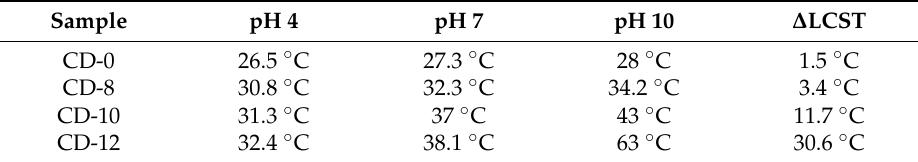
Figure 7. Plots of: ( a ) transmittance vs. temperature of poly(CD-NIPAM) and poly(CD-NIPAM-IAM) hydrogels; ( b ) transmittance vs. temperature of sample CD-0 in various buffer solutions (pH = 4, 7 and 10); and ( c ) LCST vs. pH value of 3 wt % poly(CD-NIPAM) and poly(CD-NIPAM-IAM) copolymers in various buffer solutions. Table 4. LCSTs of 3 wt % copolymers in various buffer